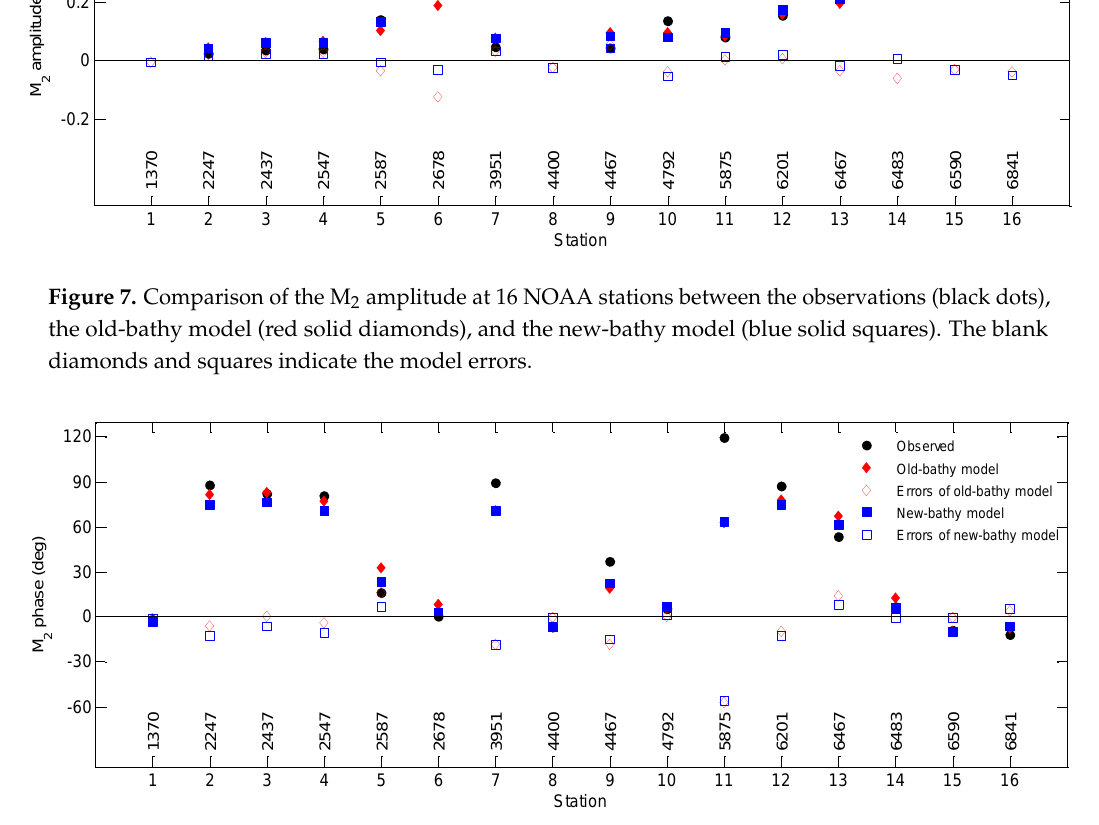
Figure 8. Comparison of the M 2 phase at 16 NOAA stations between the observations (black dots), the old-bathy model (red solid diamonds), and the new-bathy model (blue solid squares). The blank diamonds and squares indicate the model errors.